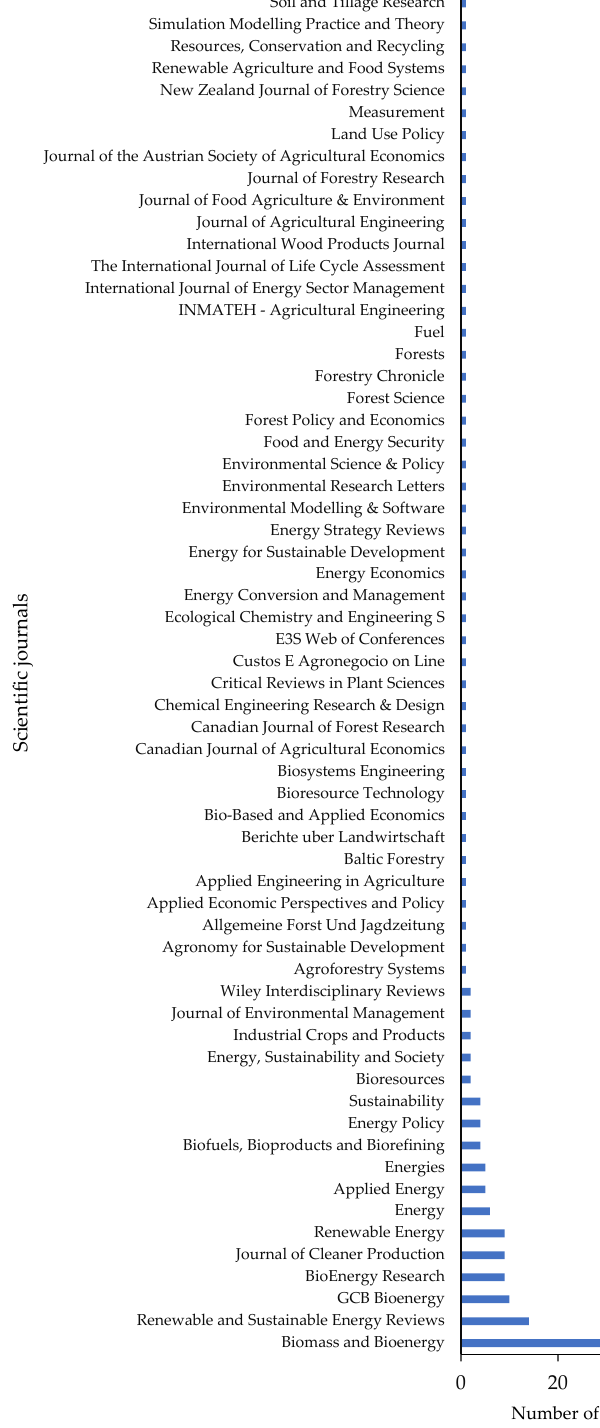
Figure 3. Scientific journals presenting papers that covered economic analysis of perennial crops for energy.